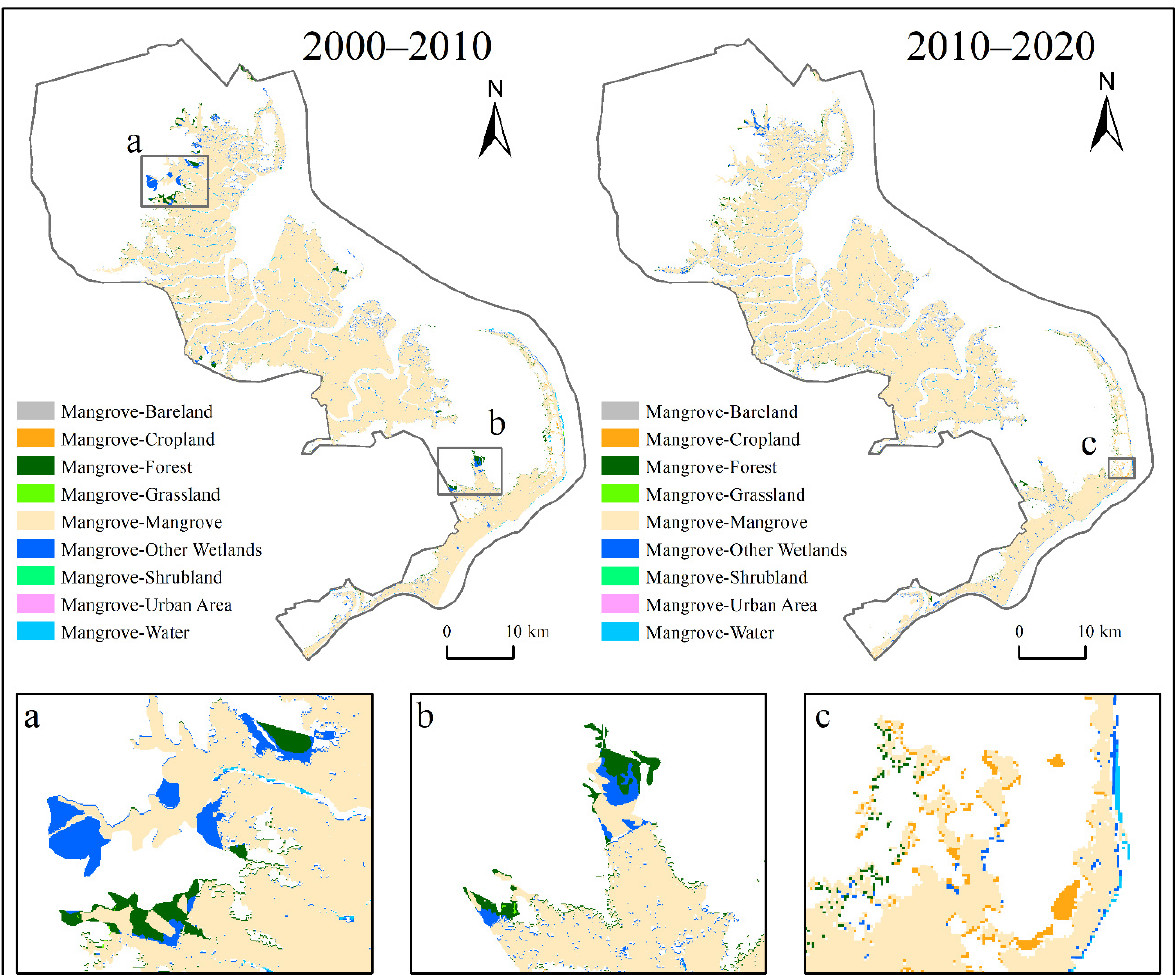
Figure 9. Maps of spatial–temporal distribution of mangrove degradation in Sembilang from 2000 to 2020. ( a ) first degradation detail picture; ( b ) second degradation detail picture; ( c ) third degradation detail picture.